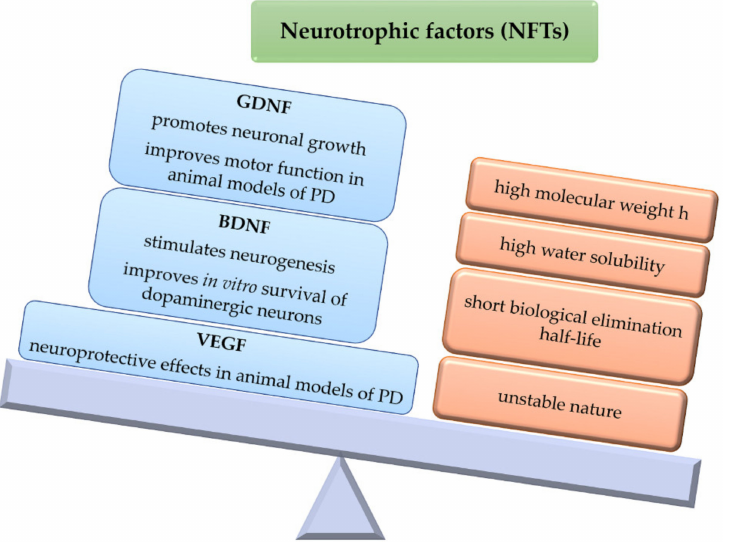
Figure 4. Neurotrophic factors. Potential mechanisms of action in Parkinson’s disease (PD). Physic- ochemical and biological characteristics. GDNF (Glial-Cell-Derived Neurotrophic Factor), BDNF (Brain-Derived Neurotrophic Factor), VEGF (Vascular Endothelial Growth